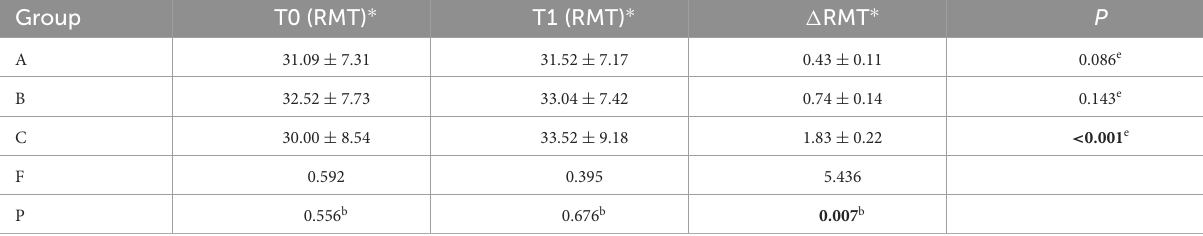
TABLE 7 Comparison of RMT scores before and after treatment among the three groups. Group